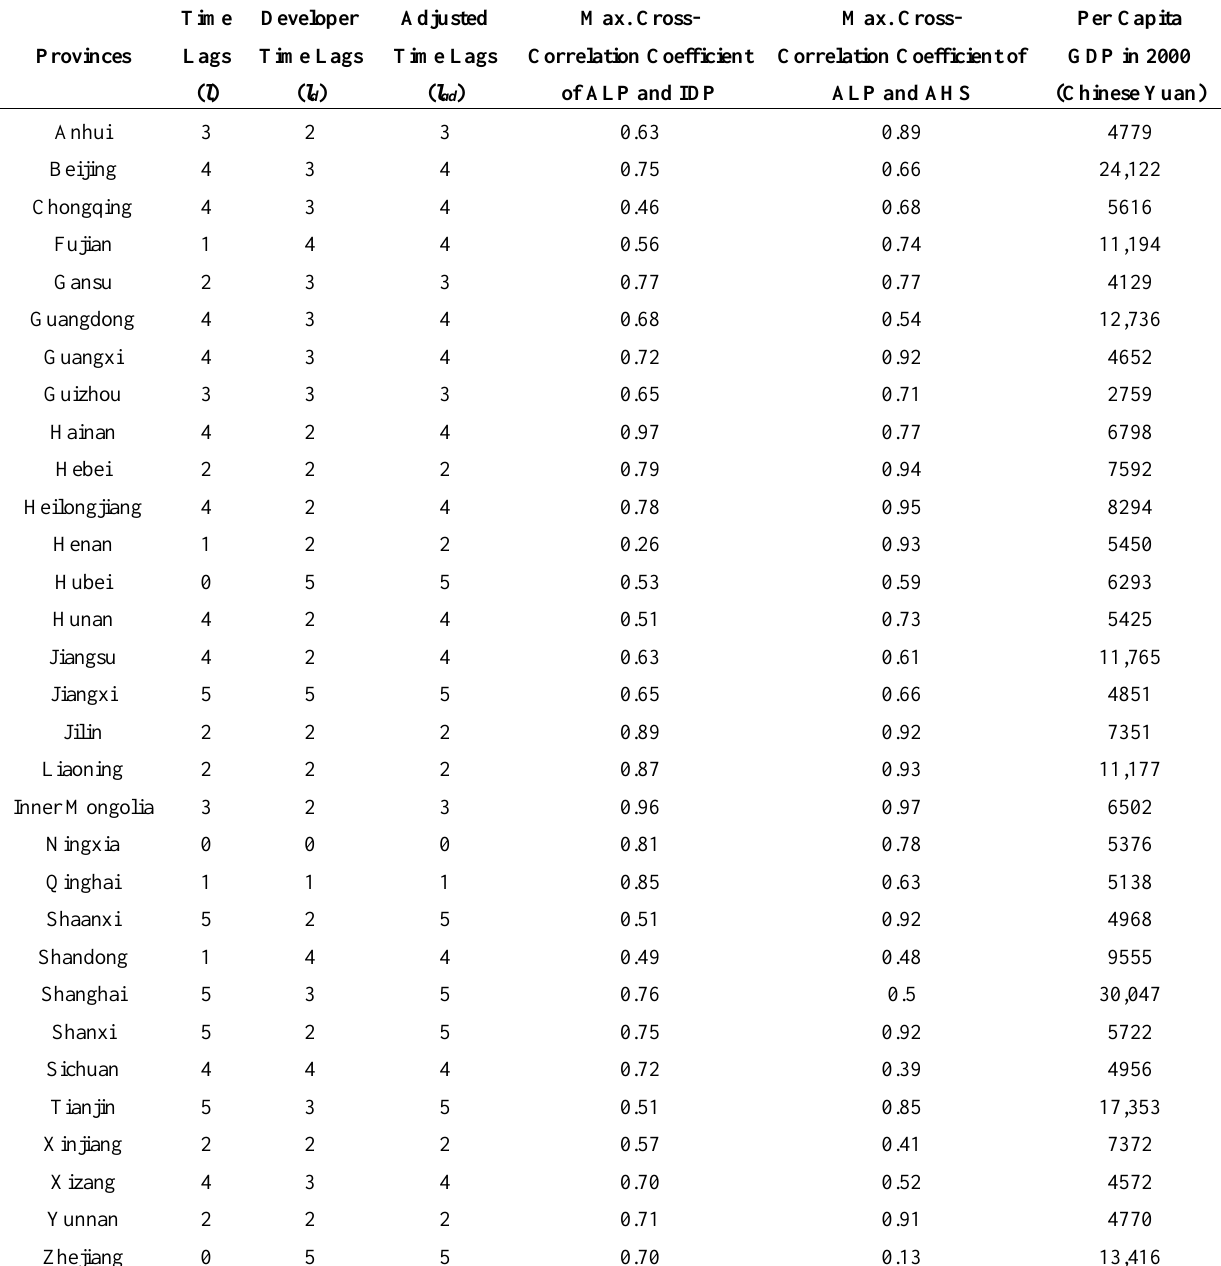
Table 3. Land development time lags ( l ), developer time lags ( l ( l ) in 31 provinces/municipalities in China between 2000 and ad